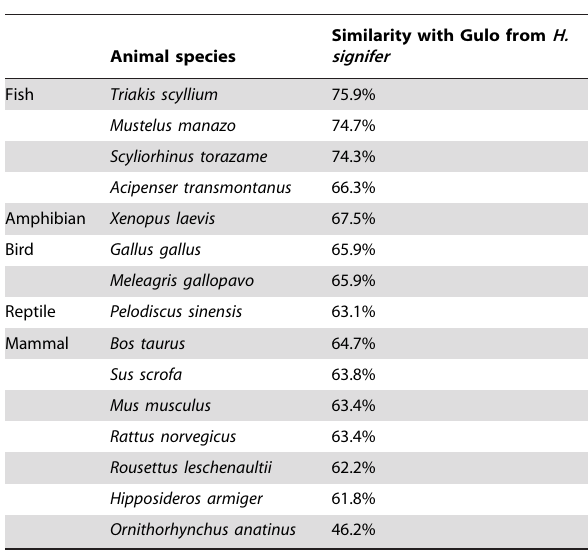
Table 1. The percentage similarity between the deduced amino acid sequence of gulonolactone oxidase (Gulo) from the kidney of Himantura signifer and those of other animal species obtained from Genbank.